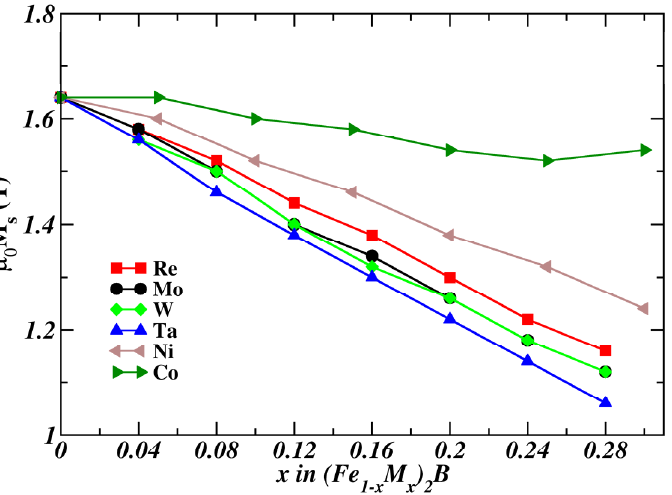
Figure 4. Composition dependence of magnetization µ 0 M s in (Fe 1 − x M x ) 2 B alloys (M = Co, Ni, Mo, W, Ta and Re).